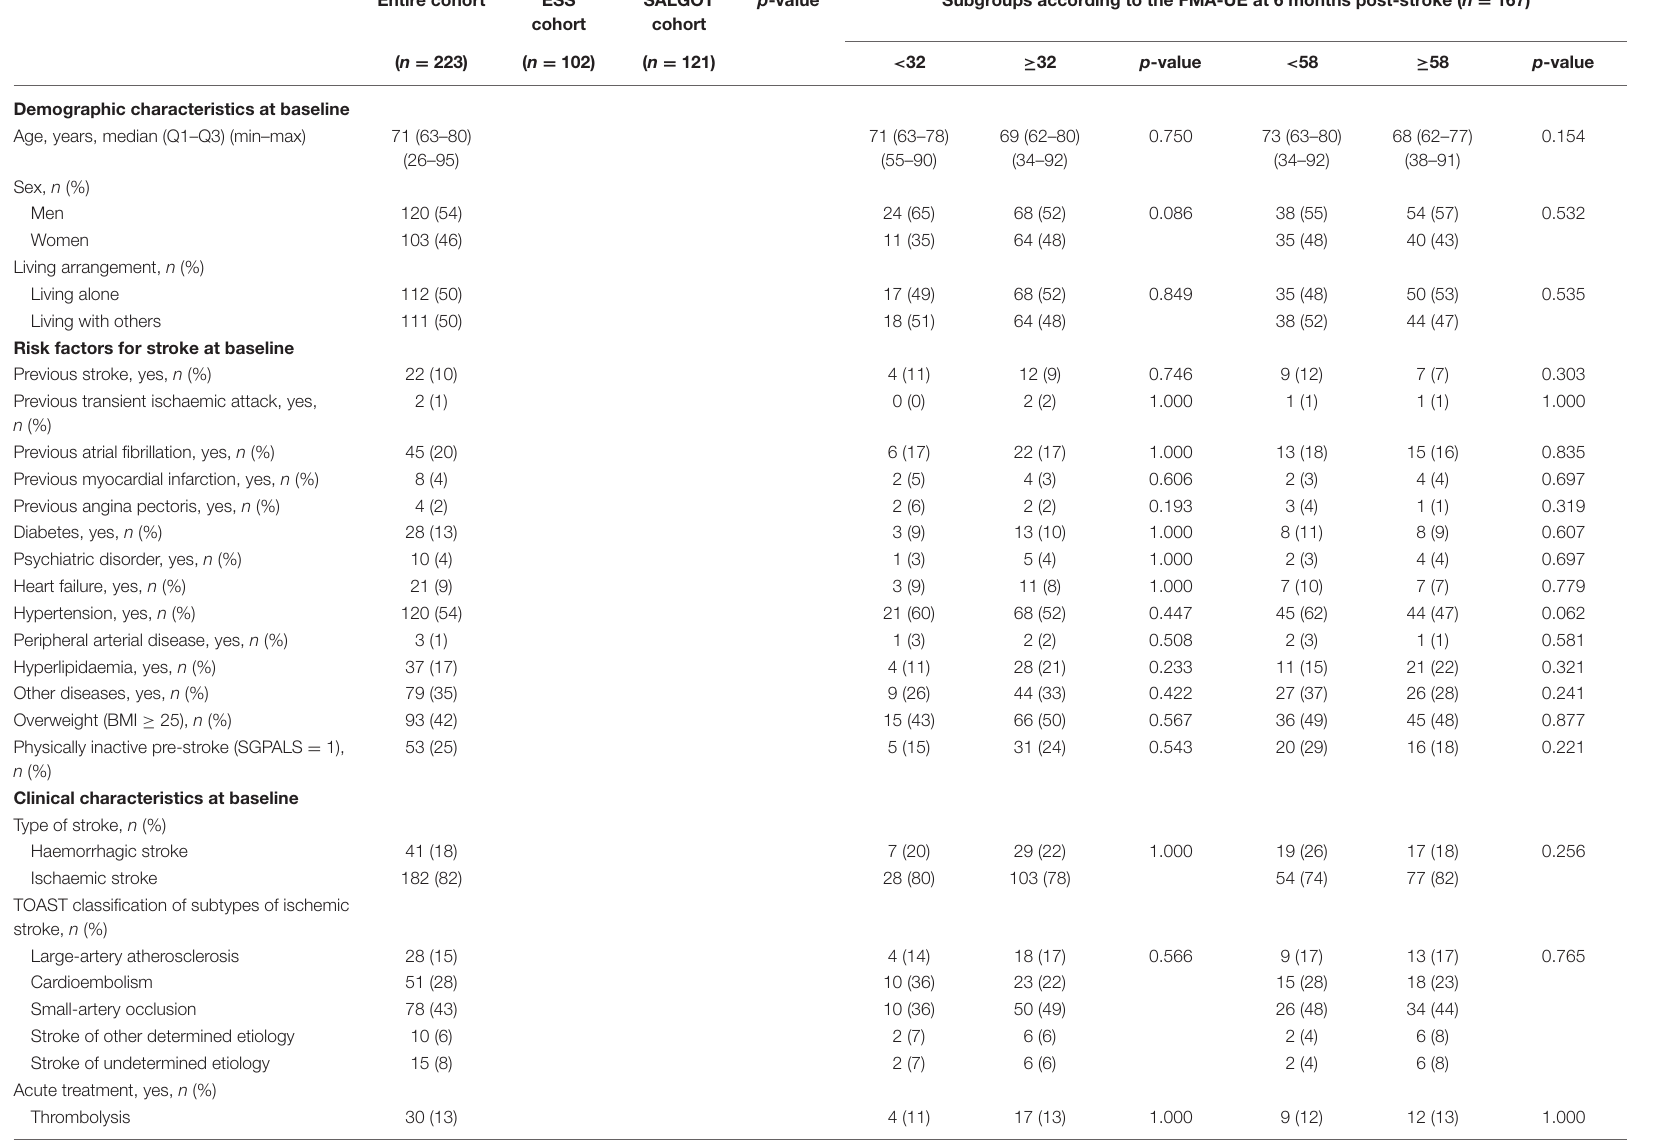
TABLE 1 | Characteristics of the